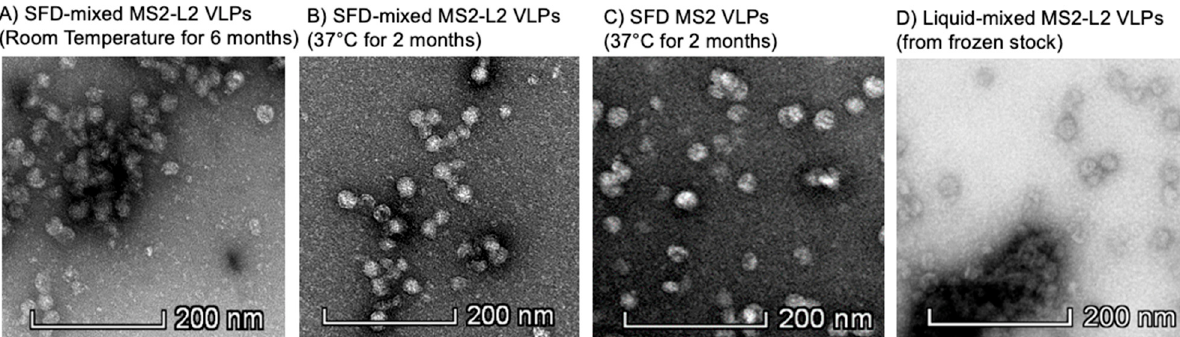
Figure 3. Transmission electron microscopy (TEM) images of spray-freeze-dried (SFD) VLPs and liquid VLPs. Spray-freeze-dried VLPs were reconstituted in PBS and analyzed using TEM. ( A ) TEM of SFD-mixed MS2-L2 VLPs stored at room temperature for 6 months. ( B ) TEM of SFD-mixed MS2-L2 VLPs stored at 37 °C for 2 months. ( C ) TEM of spray-freeze-dried control MS2 VLPs stored at 37 °C for 2 months. ( D ) Liquid-mixed MS2-L2 VLPs (from frozen stock). Images were taken at 40,000× magnification.